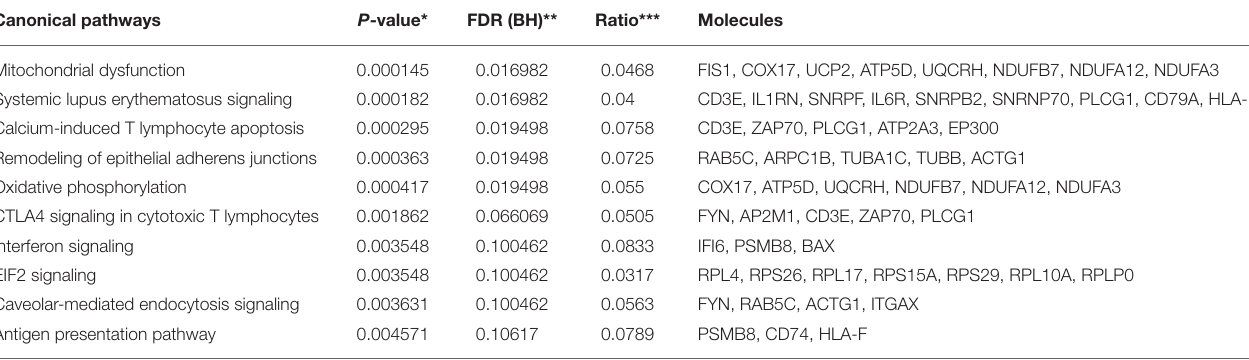
TABLE 6 | Top 10 down-regulated pathways in acute appendicitis patients vs. controls with non-specific abdominal pain. Canonical